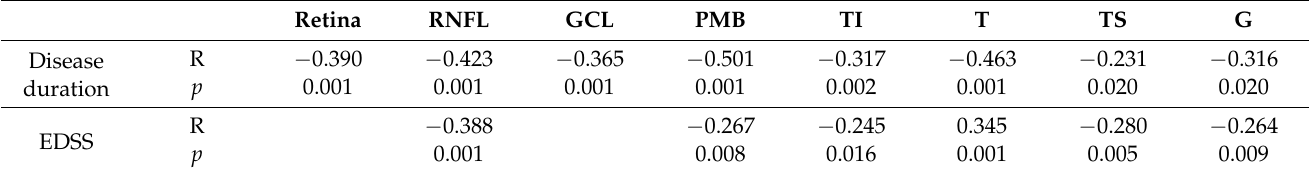
Table 4. Correlations (R) between OCT parameters and clinical parameters.